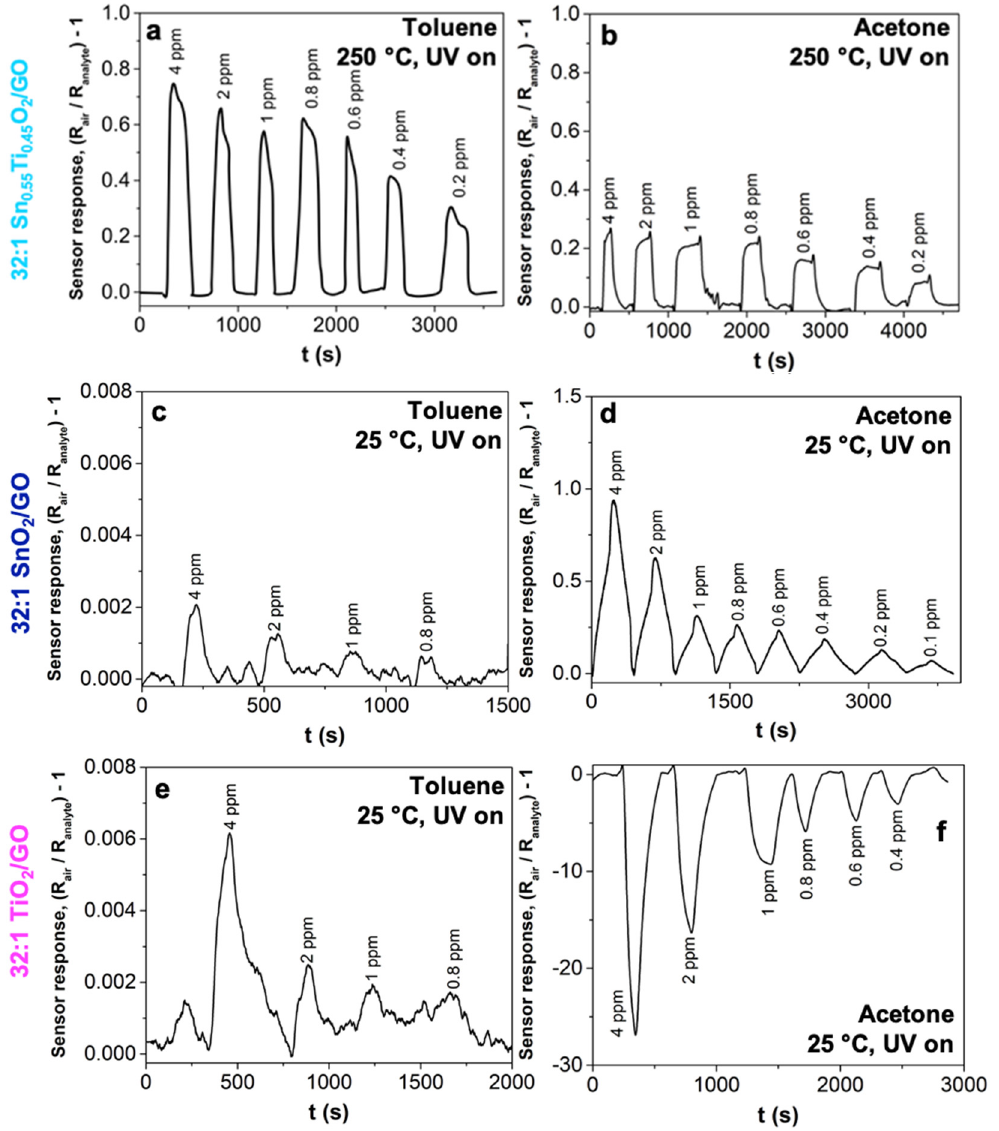
Figure 5. ( a ) Toluene and ( b ) acetone sensing by 32:1 Sn 0.55 Ti 0.45 O 2 /GO solid solution, at 250 °C with UV light. Sensor responses obtained towards ( c , e ) toluene and ( d , f ) acetone for 32:1 SnO 2 /GO and 32:1 TiO 2 /GO, at RT with UV irradiation. All the measurements were carried out in simulated air (20% O 2 – 80% N 2 ). OT = Operating Temperature.